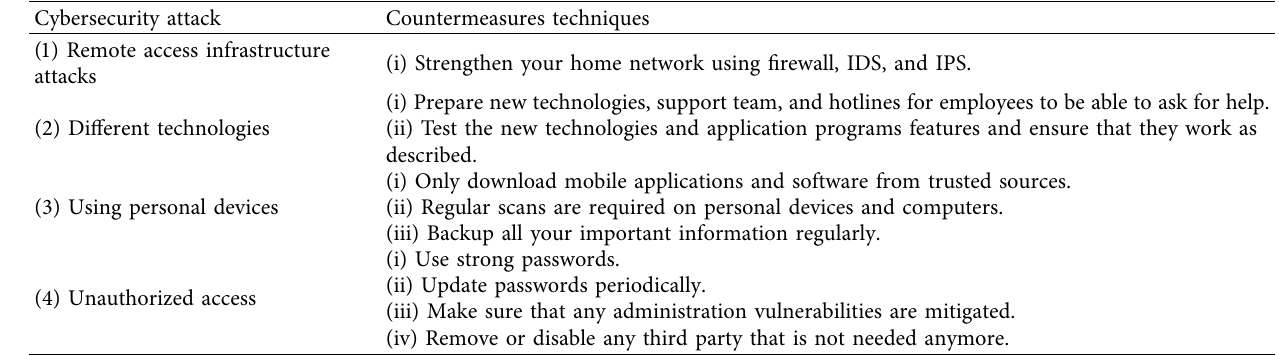
Table 3: Cybersecurity attacks and the countermeasure techniques. Cybersecurity attack Countermeasures